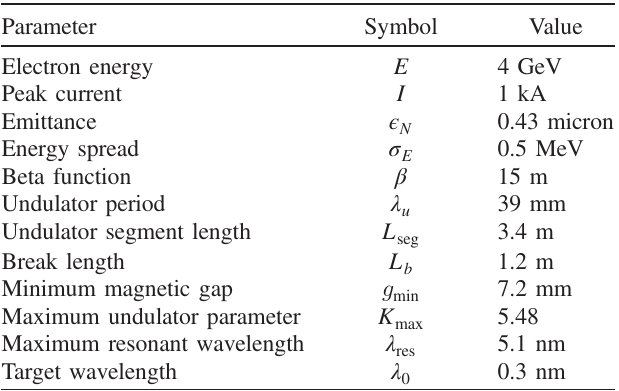
TABLE I. Beam and undulator parameters for soft x-ray beam line design for